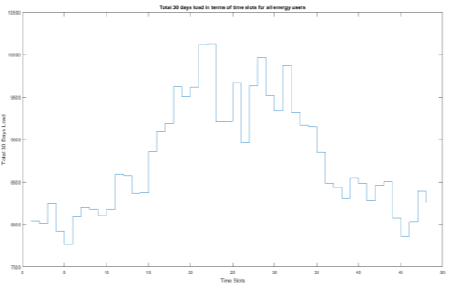
Figure 13. Total monthly energy load in each time slot